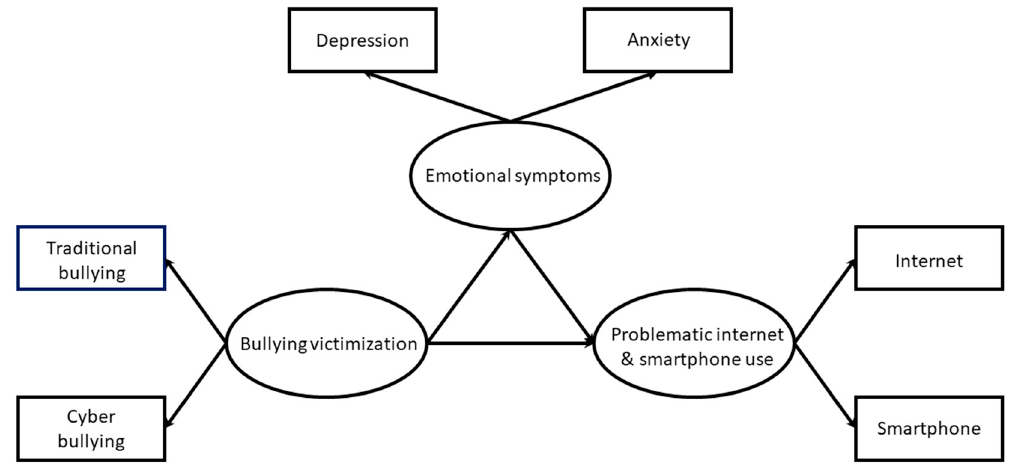
Figure 1. The conceptual model of mediating e ff ect.